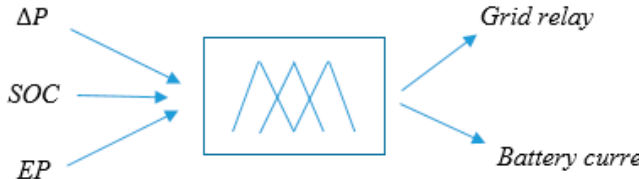
Figure 2. Fuzzy logic data processing steps.